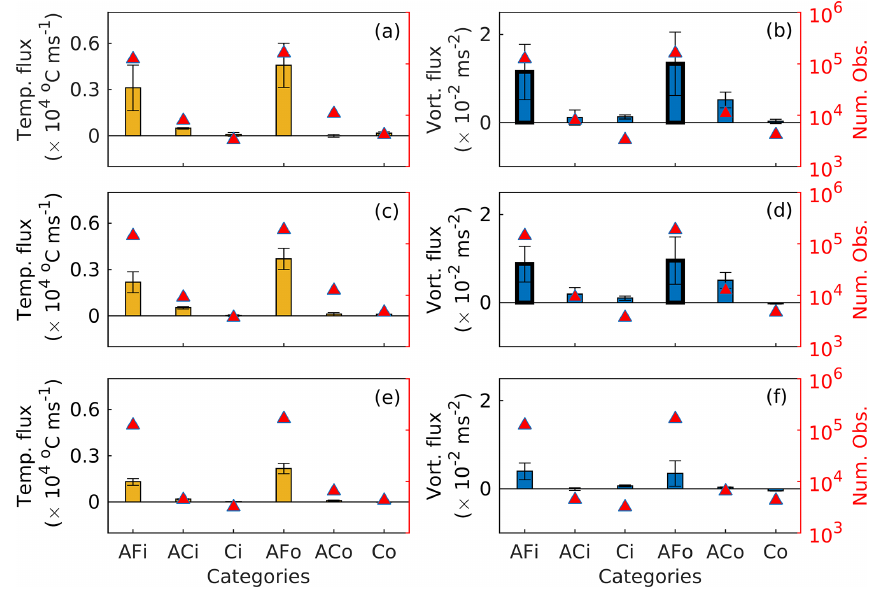
Figure 13. Estimates of the (a, c, e) net temperature flux and (b, d, f) net vorticity flux into the LB for 3D drifters deployed at (a, b) 15m, (c, d) 200m and (e, f) 500m depth. The results are shown for selected entry/exit pair categories described in Sect. 3.5. Thick black edges on AFi and AFo bars in (b) and (d) indicate that these are shown as one-third of their original size. Red triangles show the number of drifter pairs used for the calculation and are given on the right axes with a log scale. The abbreviations are as follows: AFi – ambient flow in-anything out; ACi – anticyclone in-anything out; Ci – cyclone in-anything out; AFo – anything in-ambient flow out; ACo – anything in-anticyclone out; Co – anything in-cyclone